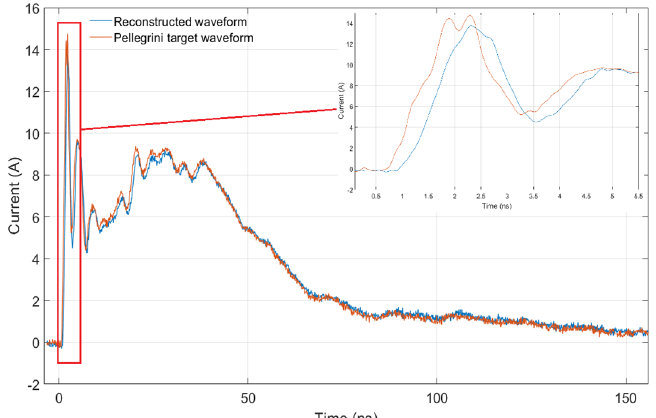
Figure 10. Comparison of the reconstructed waveform applying the proposed methodology with the Pellegrini target (reference) waveform for a +4 kV pulse of the EM TEST Dito ESD generator including a zoomed view of the initial peak. Table 4. Reconstructed and reference ESD current parameters for the Schaffner NSG 433 ESD generator.